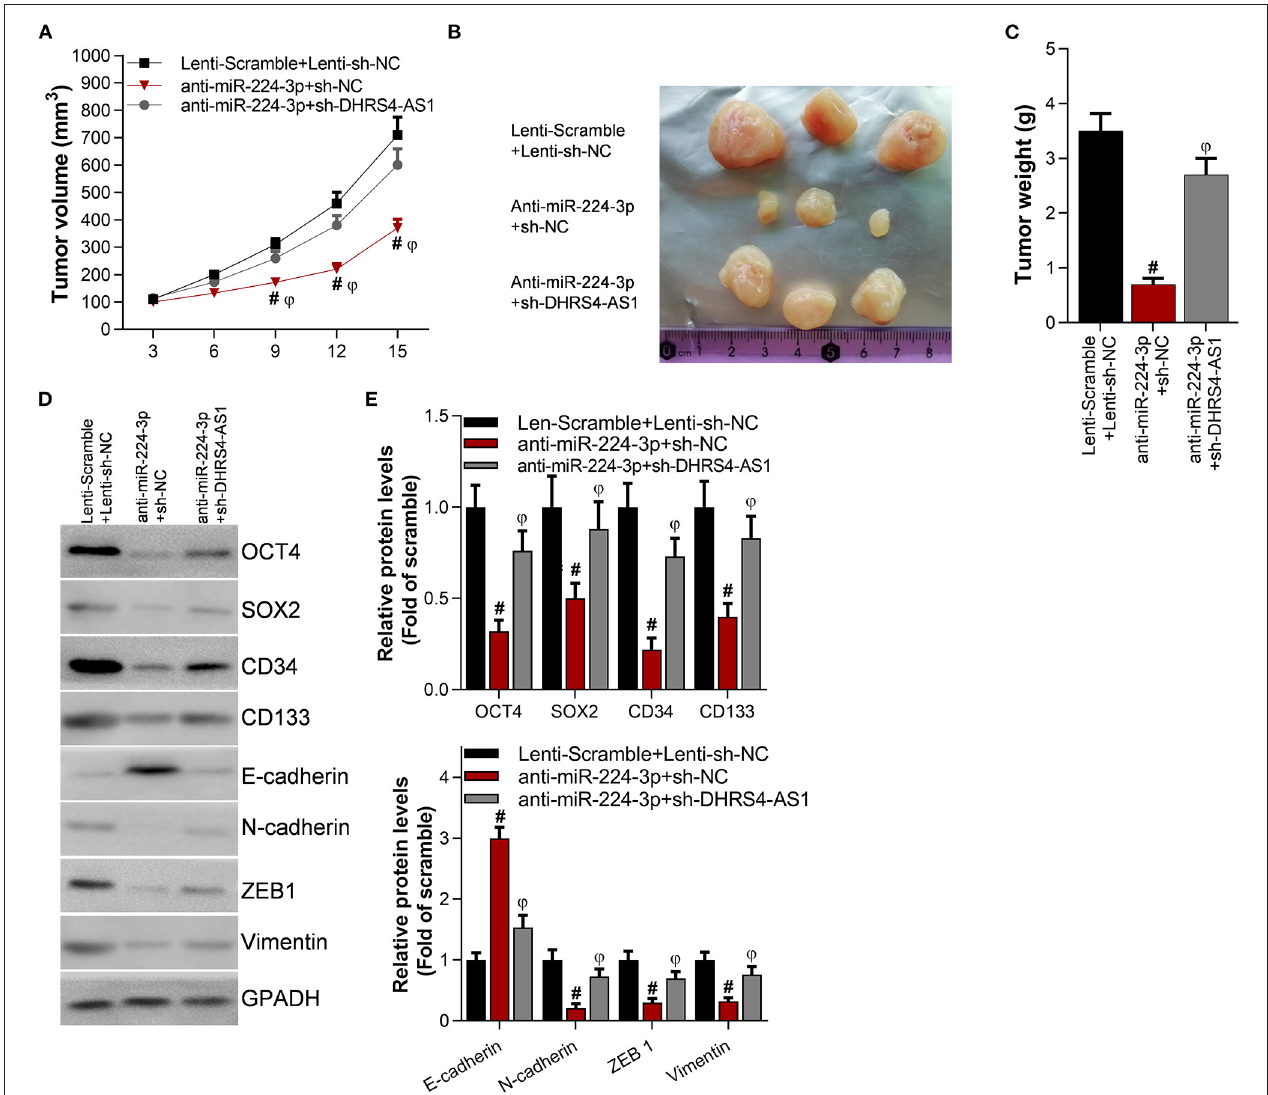
FIGURE 5 | Knockdown of DHRS4-AS1 attenuated anti-miR-224-3p-mediated tumor growth inhibition in vivo . Calu-3 cells were transfected with lenti-viruses meidatescramble, anti-miR-224-3p, si-NC, or si-DHRS4-AS1 for 48h. The infected Calu-3 cells were collected and injected into nude mice ( n = 3/group). (A) Tumor volumes were measured at the indicated times; # p < 0.01 vs. scramble + si-NC, ϕ p < 0.01 vs. anti-miR-224-3p + si-DHRS4-AS1. Tumors were collected (B) and measured (C) after injection on the 15th day. # p < 0.01 vs. scramble + si-NC, ϕ p < 0.01 vs. anti-miR-224-3p + si-DHRS4-AS1. (D,E) Western blot detected stemness-related and EMT-related markers in xenograft tumors; the optical densities of proteins were determined with ImageJ software; # p < 0.01 vs. scramble + si-NC. All results are expressed as the mean ±